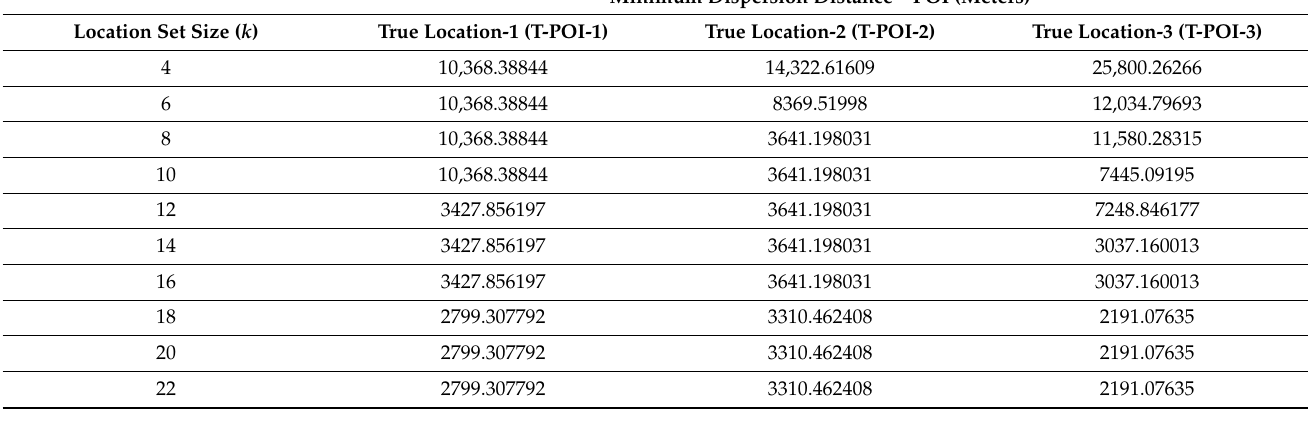
locations. input locations.